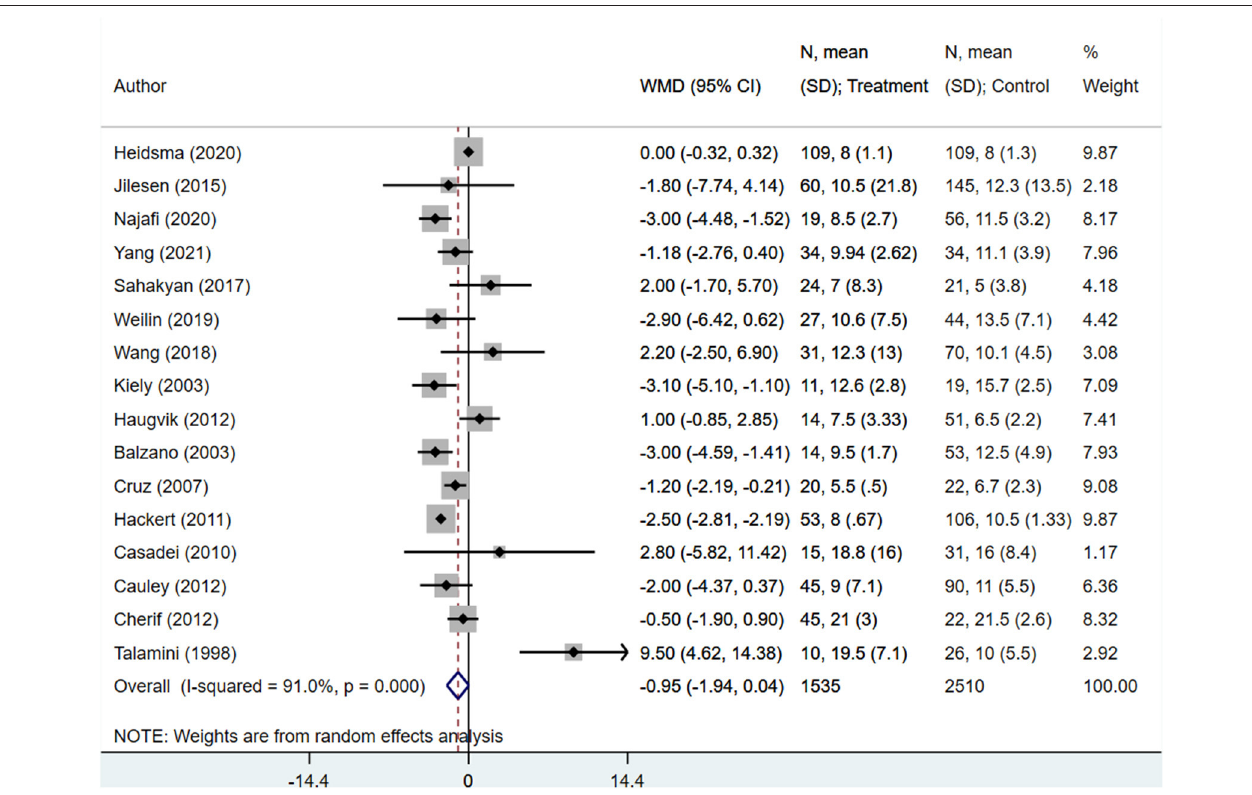
FIGURE 4 | Comparison of length of hospital stay (in days) between enucleation and standard surgical resection.